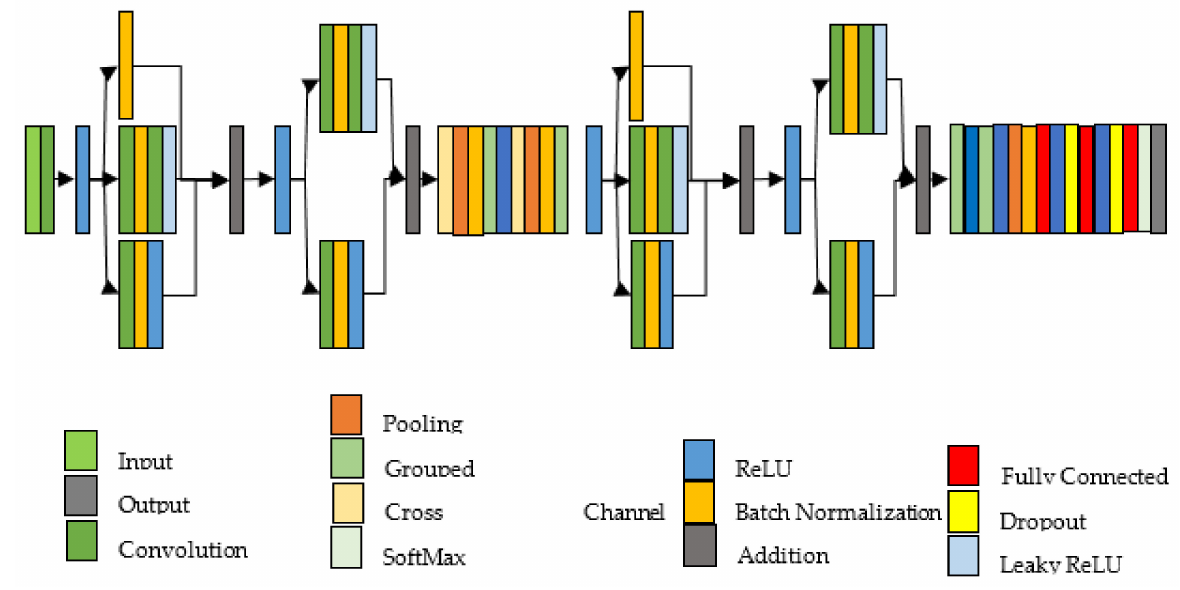
Figure 2. Architectural view of proposed model